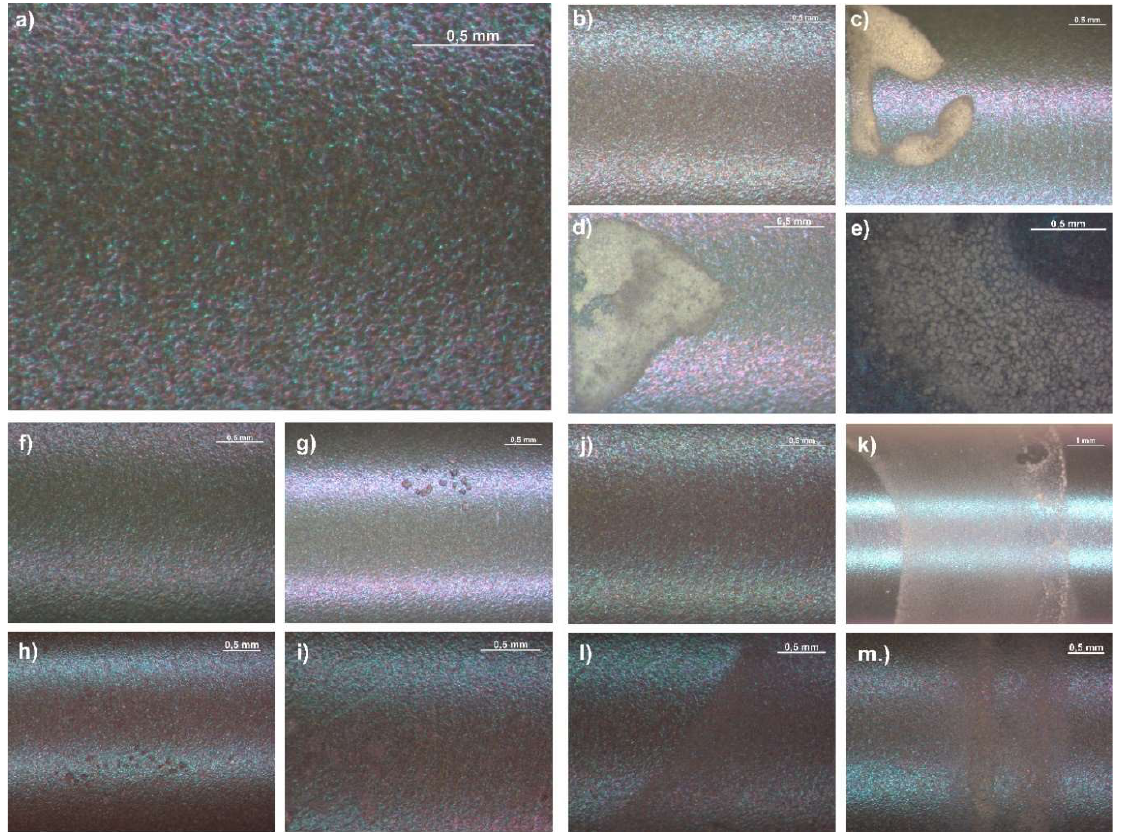
Figure 1. Surface of the: ( a ) sandblasted and oxidized Ti6Al7Nb; ( b ) P(GCap) polymer